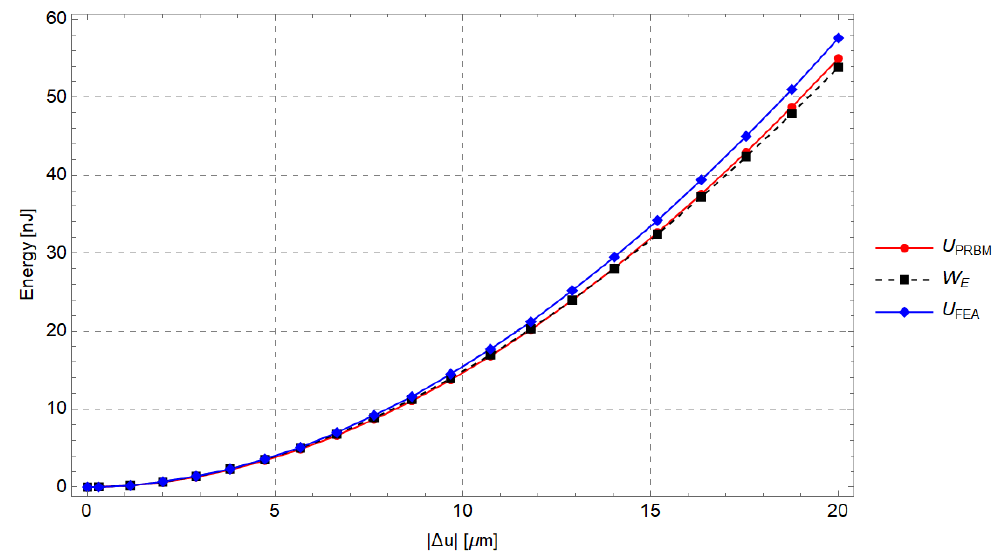
Figure 13. Comparison for increasing values of the input displacement among the strain energy of the compliant mechanism and the elastic energy of the PRBM.